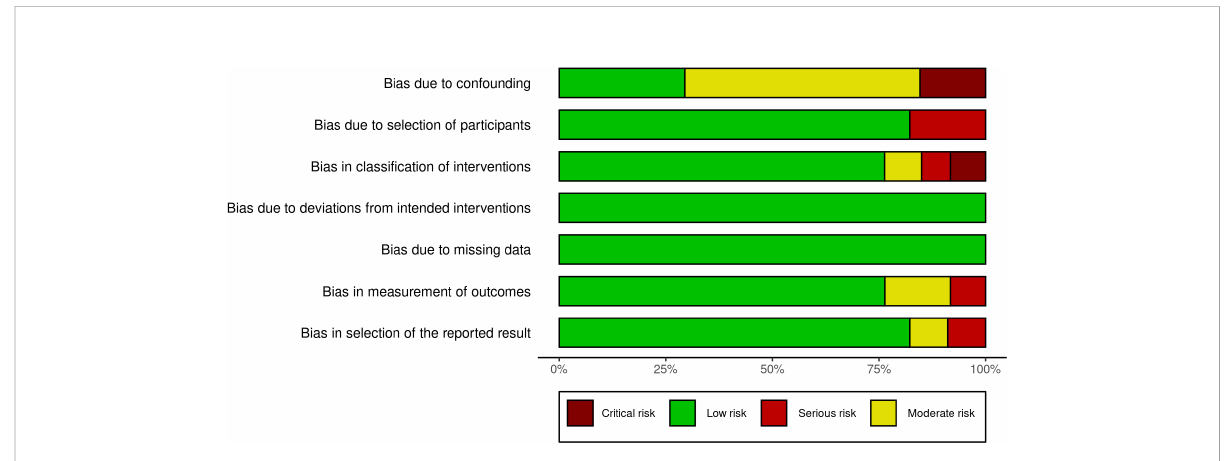
FIGURE 3 ROBINS-I Summary